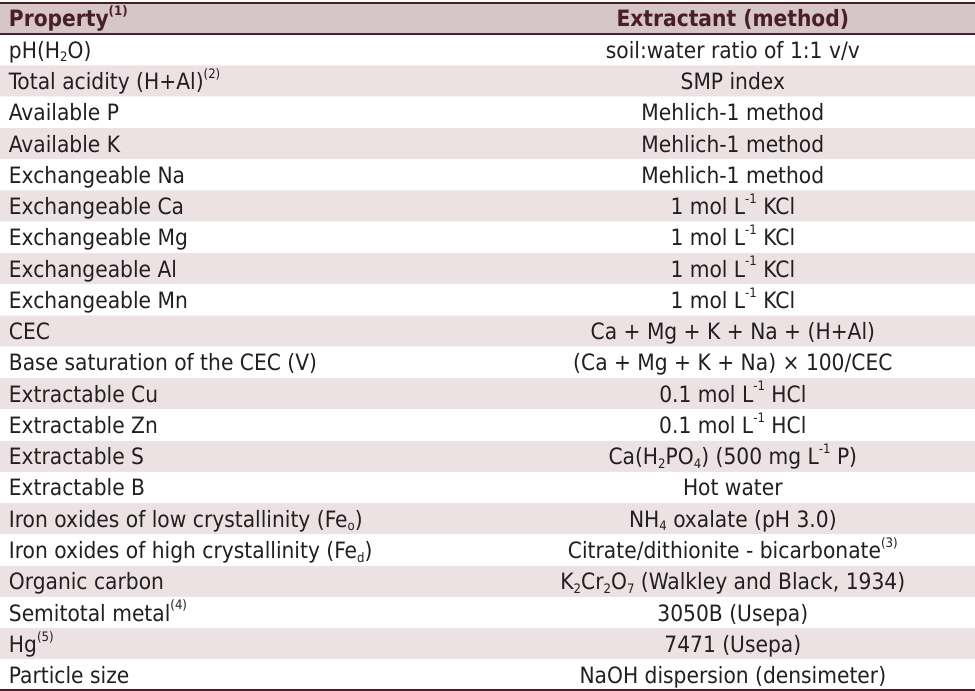
Table 2. Chemical, physical, and mineralogical properties of the soil determined in the soil groups according to table 1 and analytical methodology used Property (1) Extractant (method) soil:water ratio of 1:1